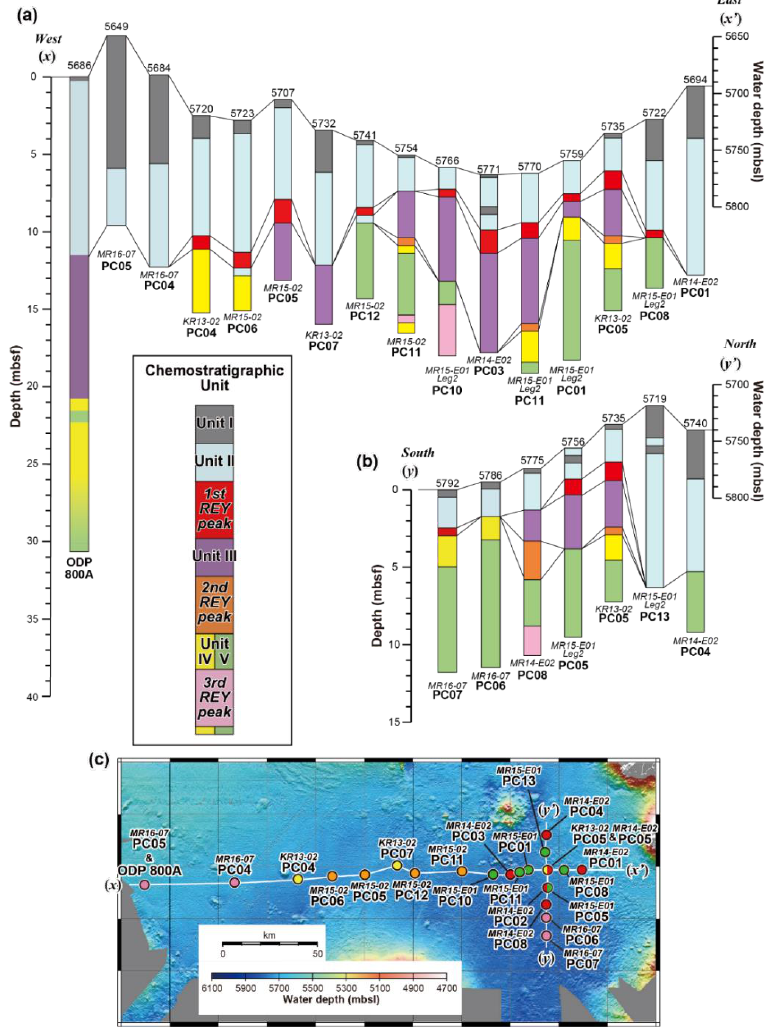
Figure 5. Chemostratigraphic correlation along representative ( a ) east–west (x–x′) and ( b ) north–south (y–y′) transects south of Takuyo Daigo Seamount, and ( c ) detailed map south of Takuyo Daigo Seamount. The vertical positions correspond to their water depth (meters below sea level; mbsl) on the right scale. Their core lengths (meters below sea floor; mbsf) correspond to the left scale.